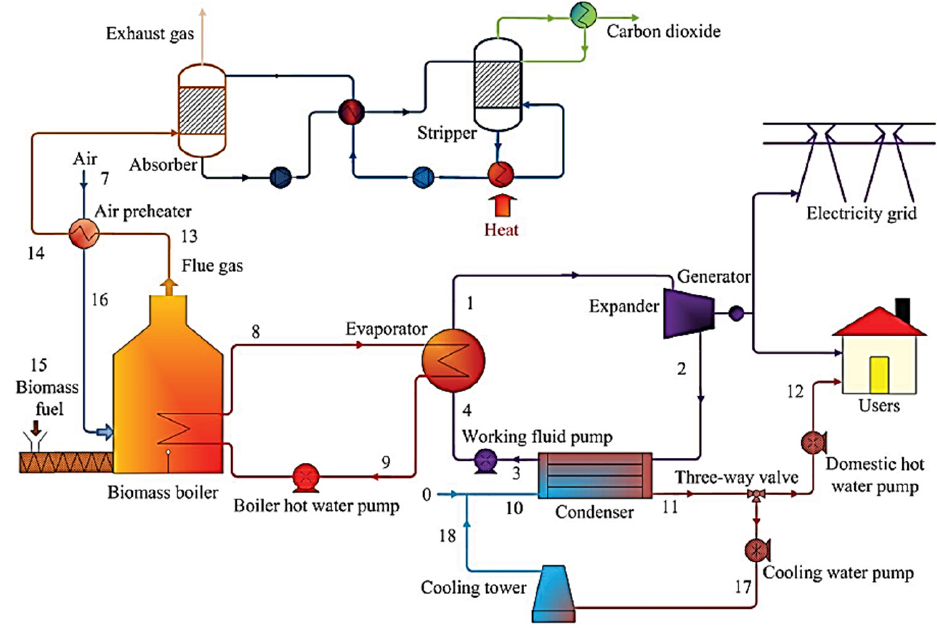
Figure 6. Schematic diagram of biomass-fired ORC-CHP system integrated with MEA-based CO 2 capture [67].